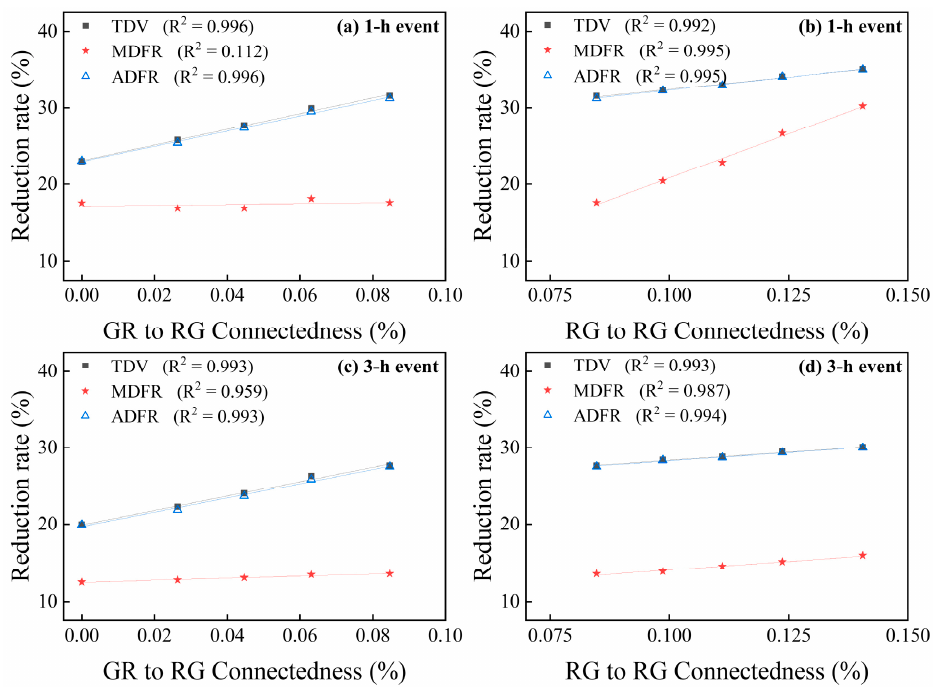
Figure 12. Effect of connectivity of SuDS components on TDV, ADFR and MDFR: ( a ) GR to RG, in 1 h event; ( b ) RG to RG, in 1 h event; ( c ) GR to RG, in 3 h event; ( d ) RG to RG, in 3 h event.